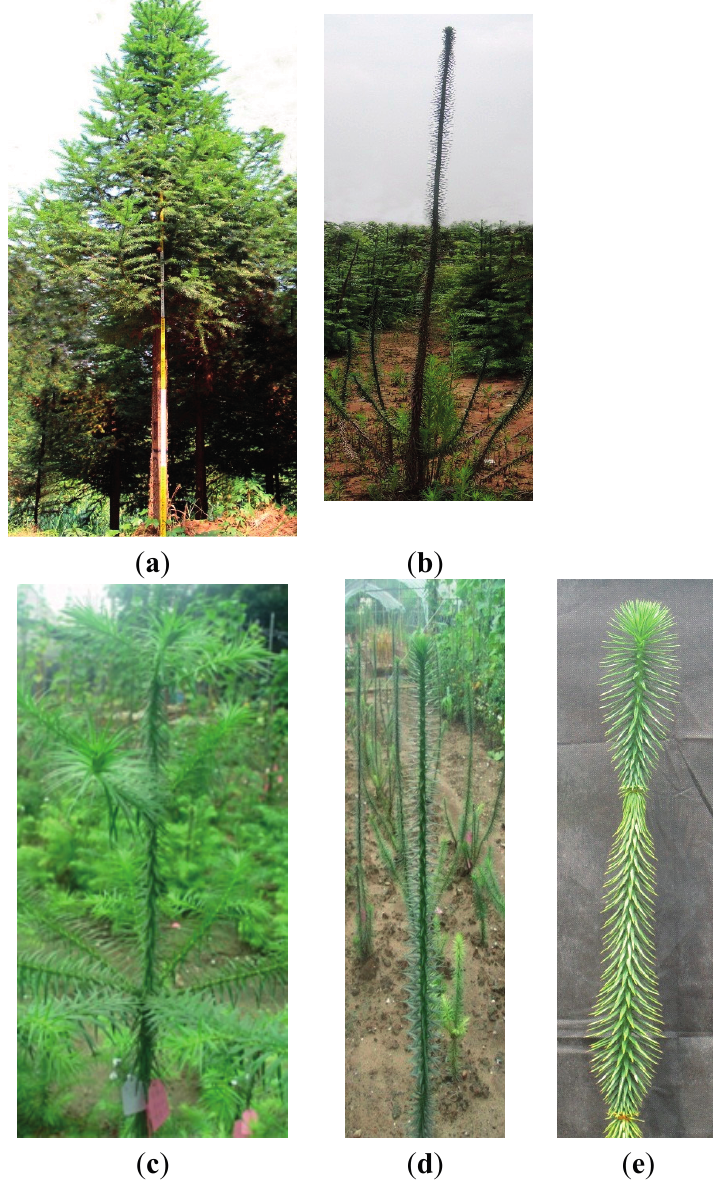
Figure 1. Phenotypes of the Chinese fir mutant line “Dugansha” and the respective wild-type No. 020. ( a ) Six-year-old tree of the Chinese fir elite genotype No. 020 (wild type), H (Height) 10.5 m, DBH (Diameter at breast height) 12 cm; ( b ) The Chinese fir mutant “Dugansha” (6 years old), H 3.0 m, DBH 2 cm; ( c ) Two-year-old cutting of the Chinese fir elite genotype No. 020 (wild type); ( d ) Two-year-old cutting of the Chinese fir mutant “Dugansha”; ( e ) Annual height growth (between the white dash-arrow bar) of